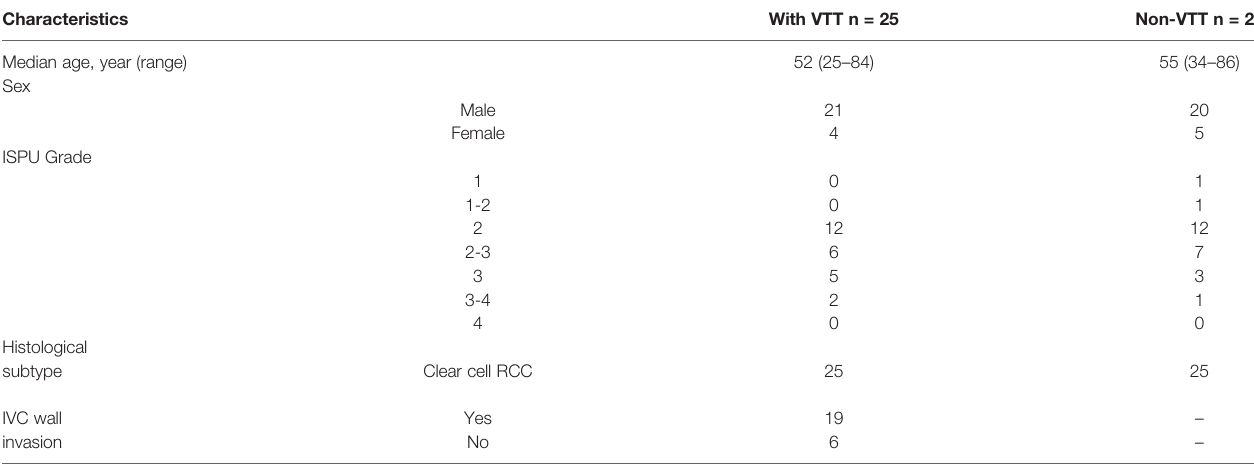
TABLE 1 | Clinical Characteristics of 50 RCC Patients.